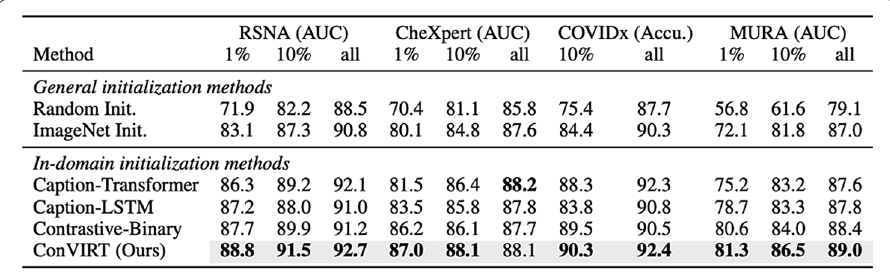
Fig. 11 AUC and Accuracy performance gains from ConVIRT (Image taken from Zhang et al.